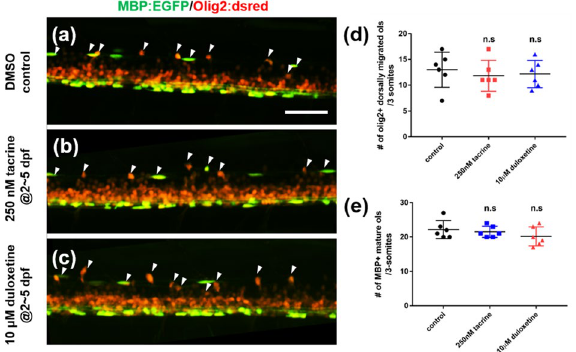
Figure 2. Tacrine and duloxetine show no effect on oligodendrocyte differentiation during development. All images are lateral views of the spinal cord of Tg(mbpa:egfp;olig2:dsred) , anterior to the left and dorsal to the top. Larvae were exposed to 0.2% DMSO ( a ), 250 nM tacrine ( b ), and 10 μM duloxetine ( c ) during dpf 2 to 5. Arrowheads indicate olig2 + dorsally migrated oligodendrocytes. ( d ) Quantification of the number of olig2 + dorsally migrated oligodendrocytes per 3-somite area. Control: 22.16 ± 2.64, 250 nM tacrine: 21.5 ± 1.64, 10 μM duloxetine: 20.16 ± 2.79. ( e ) Quantification of the number of MBP + mature oligodendrocytes per